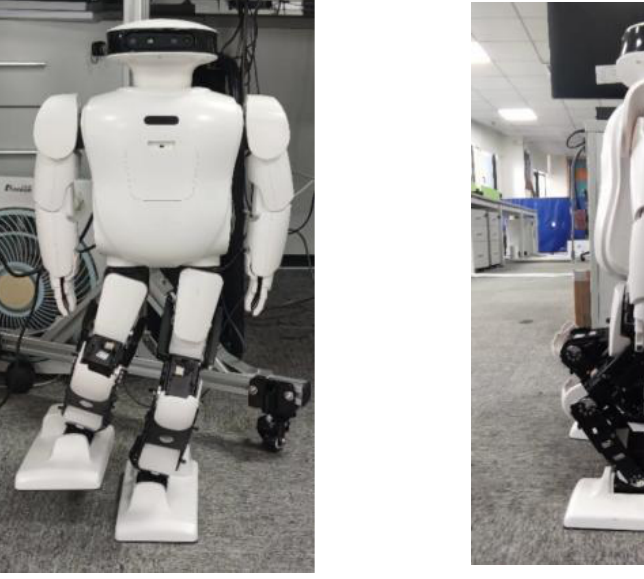
Figure 5. Roban stands on a single leg.